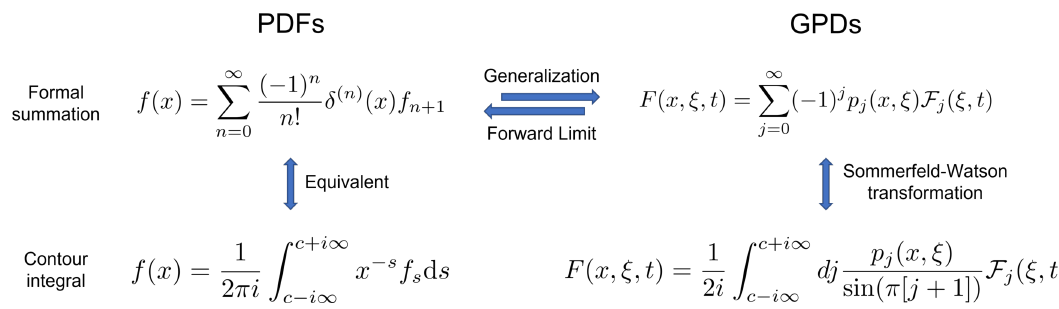
Figure 3 . A comparison of the inverse Mellin transformation expression of the PDFs and the Mellin- Barnes integral expression of GPDs together with the corresponding formal summation